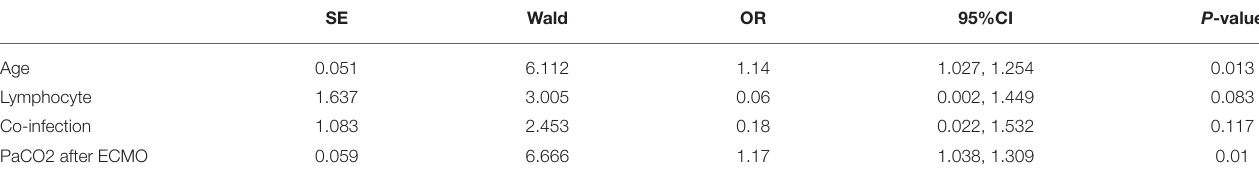
Frontiers in Medicine |